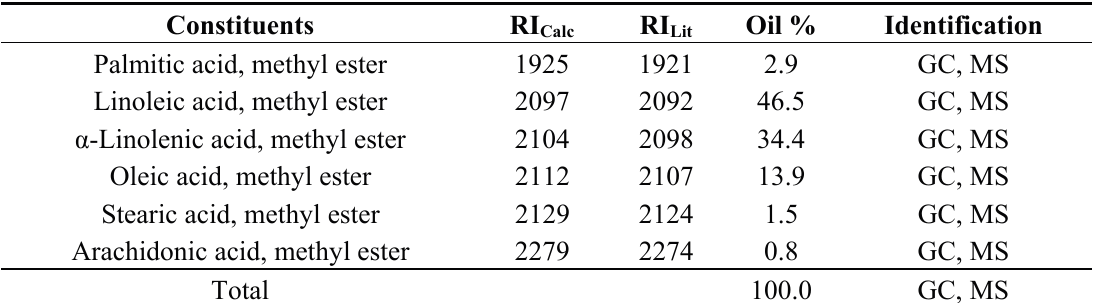
Table 1. Methylated fatty acids of the oil of Plukenetia polyadenia